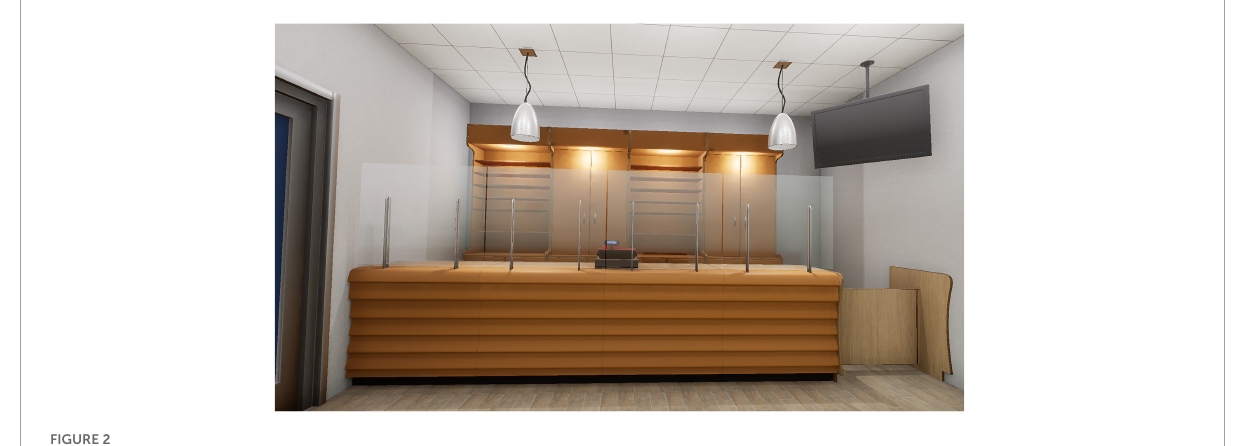
FIGURE2 An empty tobacco store.